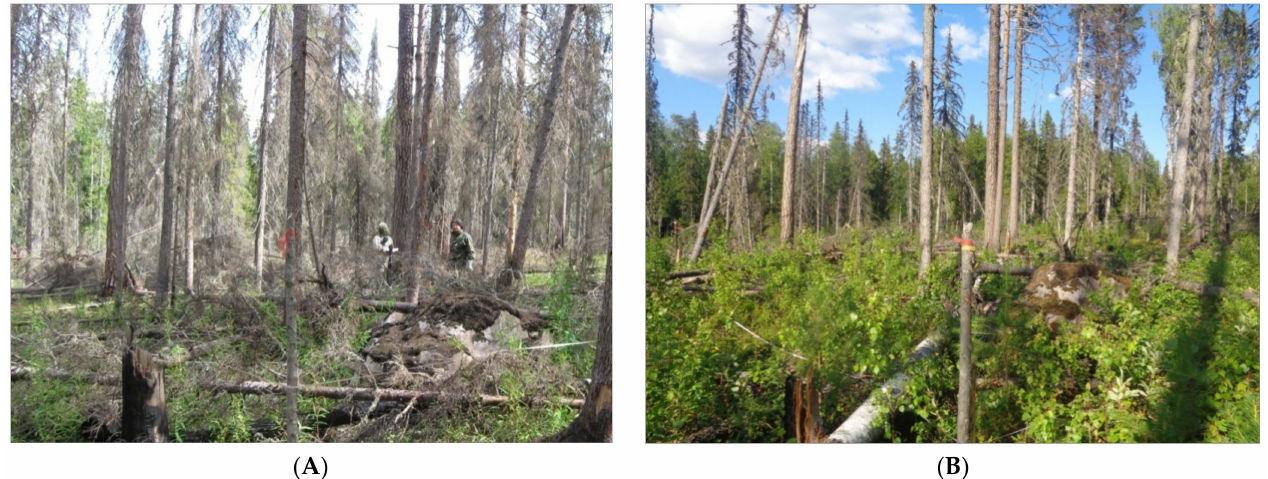
Figure 2. Spruce forest site burnt by medium-severity surface fire (SP 6) 3 years ( A ) and 10 year ( B ) after the disturbance. The fire in SP 8 was of medium severity according to fire impact indicators; the forest floor depth reduction was 80%. The fire impact (and the subsequent pest infection) killed the spruce component of the stand almost entirely, but 3 years after the fire 90% of it (in volume) still remained standing, probably due to less severe fire damage to root systems (Figure 3A). Occasional undersized living spruce trees have survived. The cover of downed deadwood was 5.0%. The survey of the plot in 2020 showed that over 70% by volume of spruce trees that had died back after the fire were uprooted. The remaining dead standing tree volume was 29% of the original (Figure 3B).